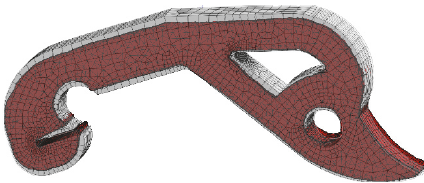
Figure 10: von Mises stress, ‖𝜎(𝑥, 𝑉 ∗ 𝛾 ∗ )−(1/3) tr [𝜎(𝑥, 𝑉 ∗ 𝛾 ∗ )] 𝐼 ‖ , in the reduced mesh G R ∗ .